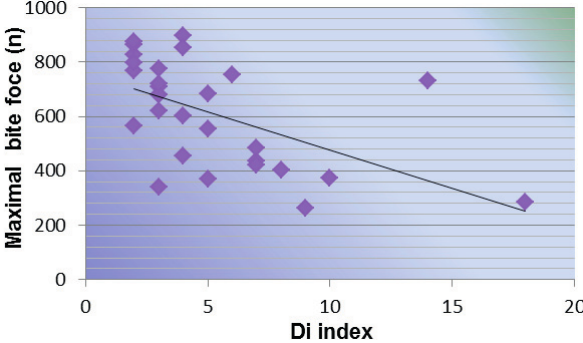
Fig. 4. Correlation between maximum bite force and dysfunc- tion index